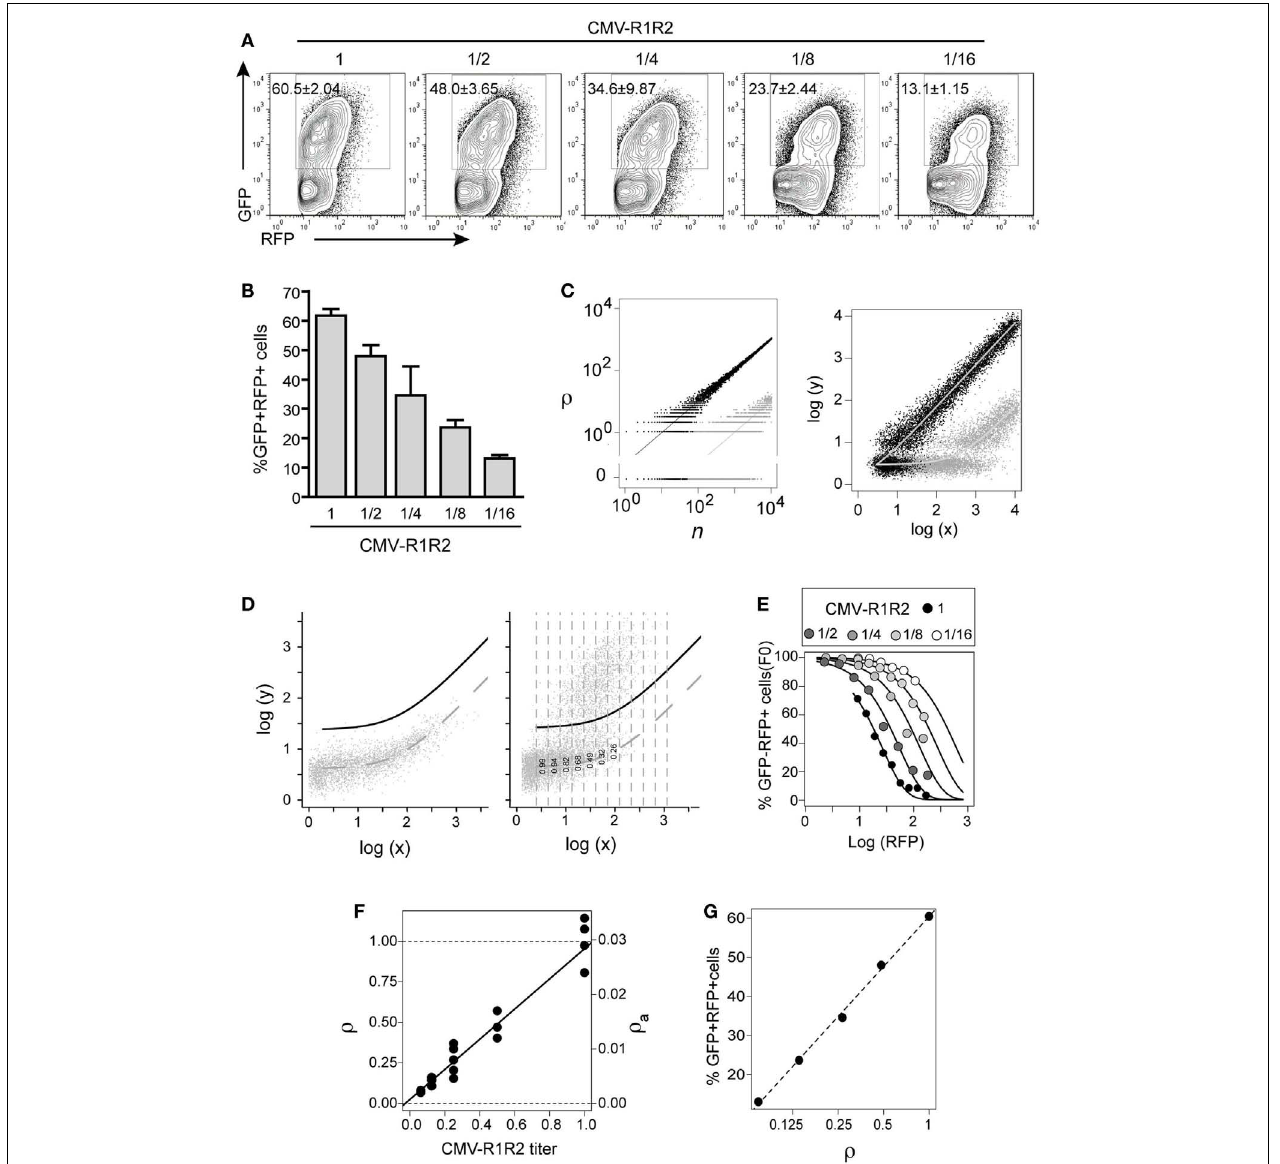
log-intensities measured in cells transfected with GFPi alone (without RAG) were fitted by the model log(y) = log( x 0 + bx ), by least square minimization and minimization of residuals mean and trend.The dashed curve represents the best fit and the full black curve represents the best fit added by four times standard deviation of the residuals. Right panel: experimental bivariate GFP vs. RFP log-intensity measurements in cells co-transfected with RAG were binned according RFP log-intensity and the frequency of GFP − cells in each bin scored (i.e., with GFP values below the black curve). (E) Fitting the model P(r = 0) = exp( − ρ a (x − x 0 )) to the experimental data.The frequency of GFP − cells was plotted vs. the mean RFP log-intensity per bin for the cells with serial dilutions of CMV-RAG1/2 constructs (A) , and fitted by the model. (F) The relative and apparent recombination coefficients (respectively ρ and ρ a ) in RAG titration experiments are proportional to the expected RAG activity.The estimates of ρ a obtained by model fitting (as in (D) were normalized such that the relative recombination coefficient ρ at the highest titer is 1. Both sets of value are plotted as a function of the CMV-RAG1/2 titers, ρ = 0.0007 + 0.028[CMV-R1R2], ρ = 0.02 + 0.93[CMV-R1R2]. (G) The a frequency of GFP + cells inside the RFP + gate (as in B ) is proportional to the logarithm of the relative recombination coefficient ρ